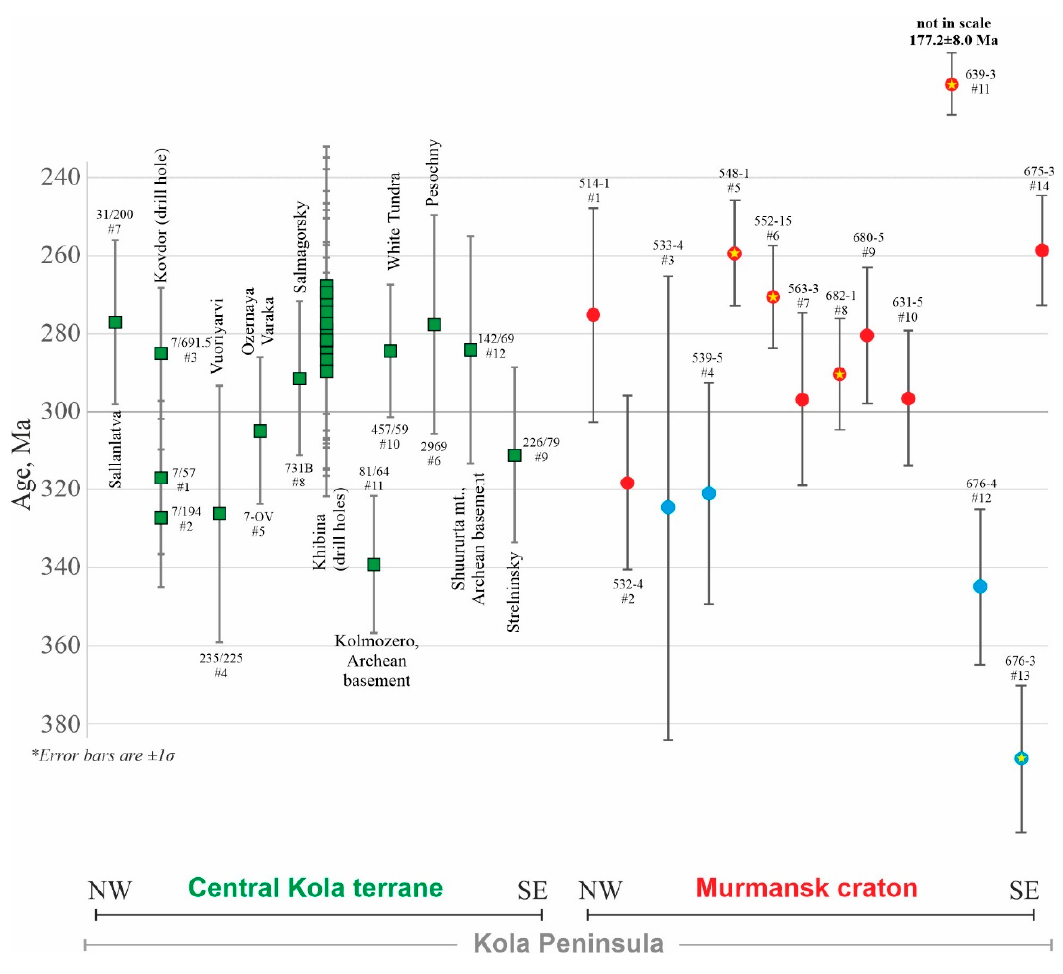
Figure 2. Distribution of the Kola Peninsula apatite fission ‐ track ages: green—previously published [1,7], red and blue—this work. Blue points—AFT ages of gabbro samples (see text). Sample numbers are given according to the corresponding tables in cited works and Tables 1 and 2 (Murmansk craton, this study). Points with yellow stars mark the AFT data, that meet the modern reliability criteria [28]: number of crystals counted ≥ 20, number of track lengths measured ≥ 50. For each tectonic unit (Central Kola terrane and Murmansk craton), samples are arranged from NW to SE. Mean track lengths vary between 14.40 ± 0.4 and 13.08 ± 0.2 µ m; the most reliable ( n ≥ 50)